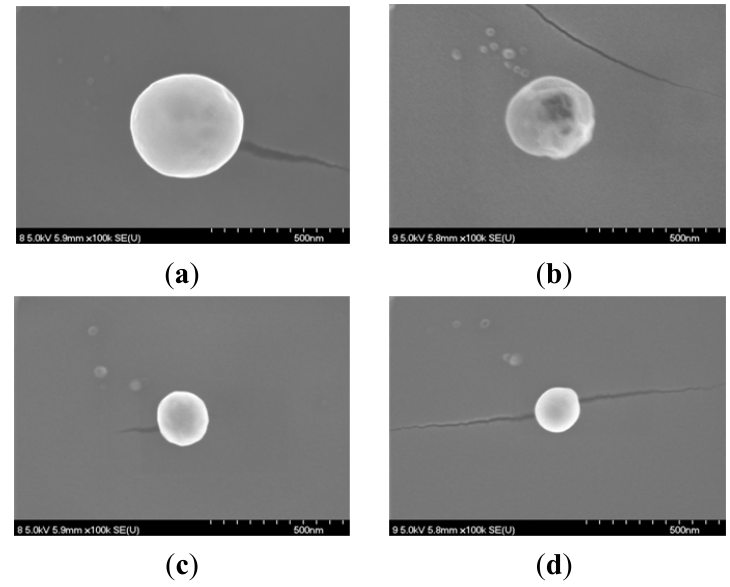
Figure 6. Scanning electron microscopic images of the Ag/PAAc nanogel; PAAc 1 wt%, Hexane 3 wt%, AgNO 0.005 M ( a ) 0 kGy, ( b ) 10 kGy, ( c ) 30 kGy, ( d ) 75 kGy, 3 ( e ) 100 kGy and ( f ) 150